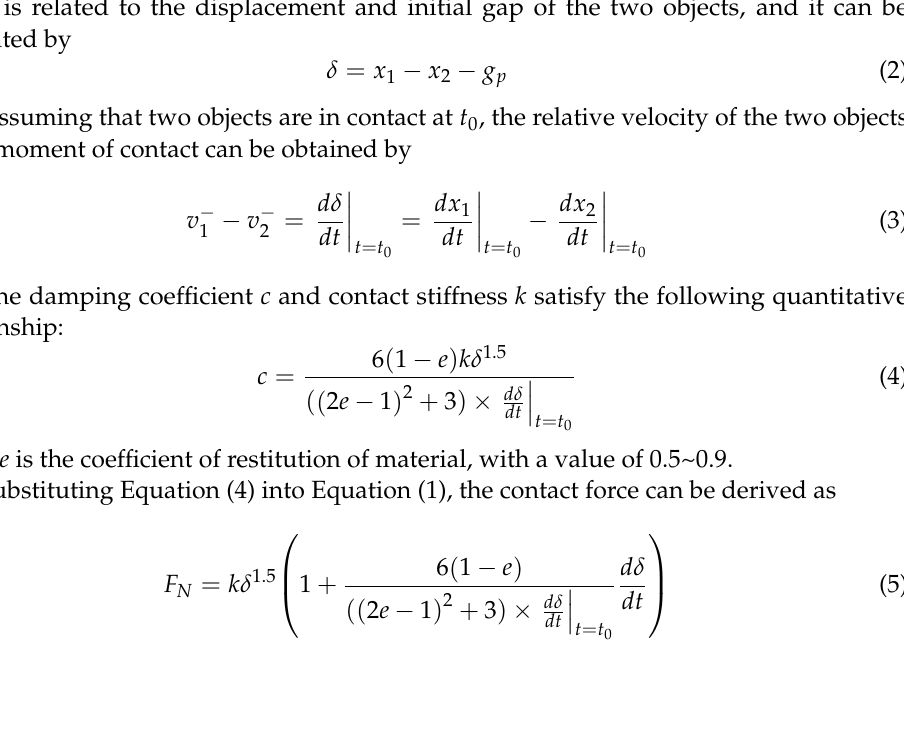
Figure 3. Module division and power transmission of non ‐ return mechanism.